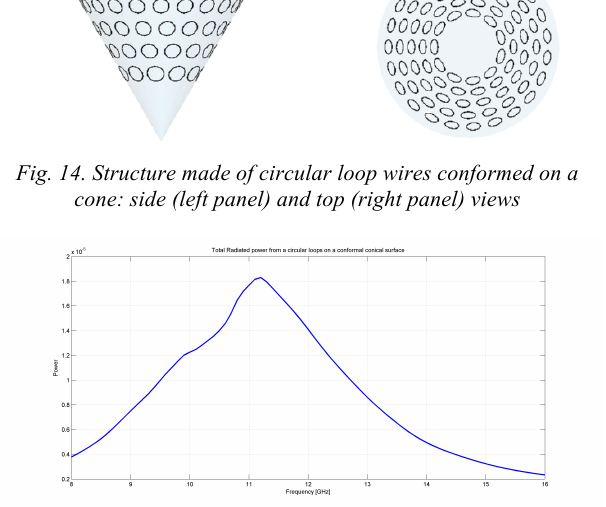
Fig. 15. Total scattered power for plane wave incidence